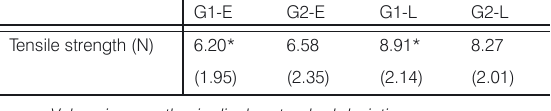
Values in parenthesis display standard deviation. G1-E vs. G2-E : p>0.05 Table 3. The means for histopathological scores.